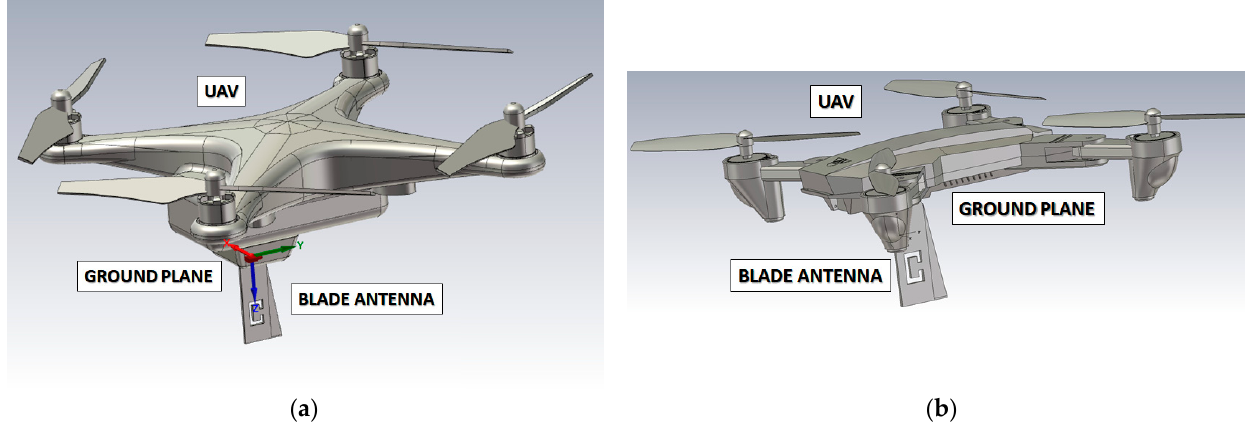
Figure 10. DJI Phantom 3 ( a ) and Mavic Pro ( b ) drone models with the aluminium blade antenna placed below the body.